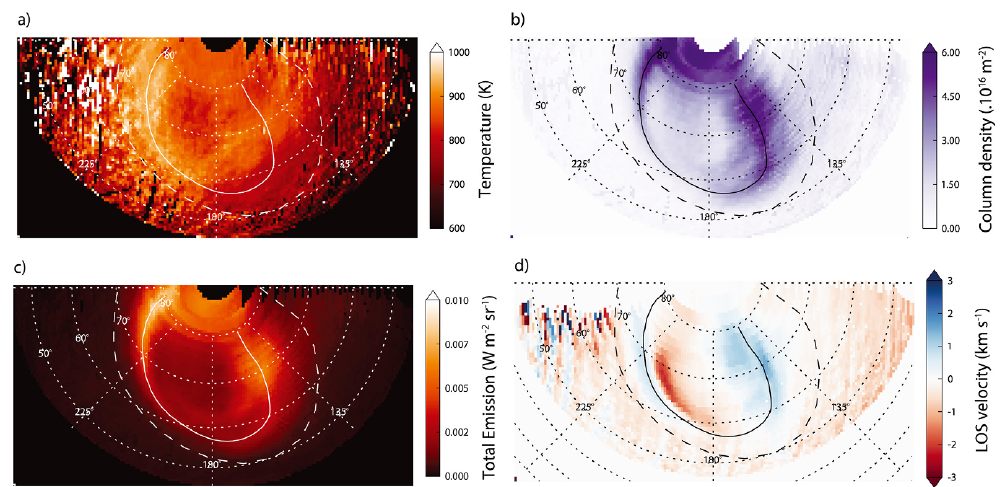
Figure 4. Polar projection of Jupiter’s northern hemisphere showing H + parameters on 31 December 3 2012. Longitudes are magnetic System III, and the latitudes are planetocentric. The white line denotes the position of the main auroral oval [61]. The dashed white line indicates the magnetic footprint of Io [62]. Panels highlight the key H + parameters ( a ) temperature, ( b ) average column density, 3 ( c ) average total emission, and ( d ) the line-of-sight velocity. Figure taken from